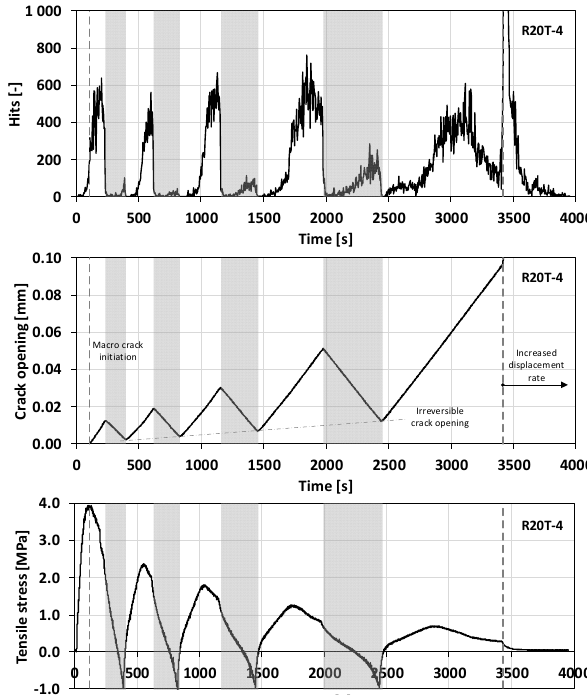
Figure 10. Cyclic tensile test results summarized as Hit ‐ time relation (upper), Crack opening ‐ time relation (middle) and Stress ‐ time relation (lower) for R20T ‐ 4.